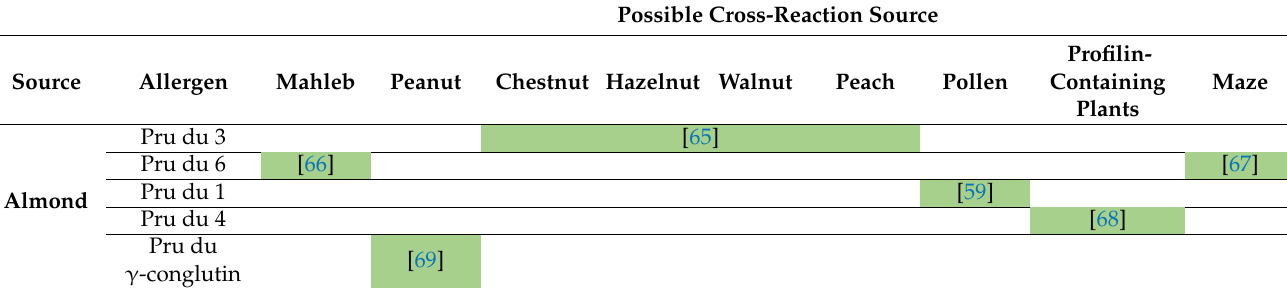
Table 1. Almonds’ most common cross reactions with other relevant sources of allergens. Green areas represent a positive association between almond allergens and other allergens of the respective sources.